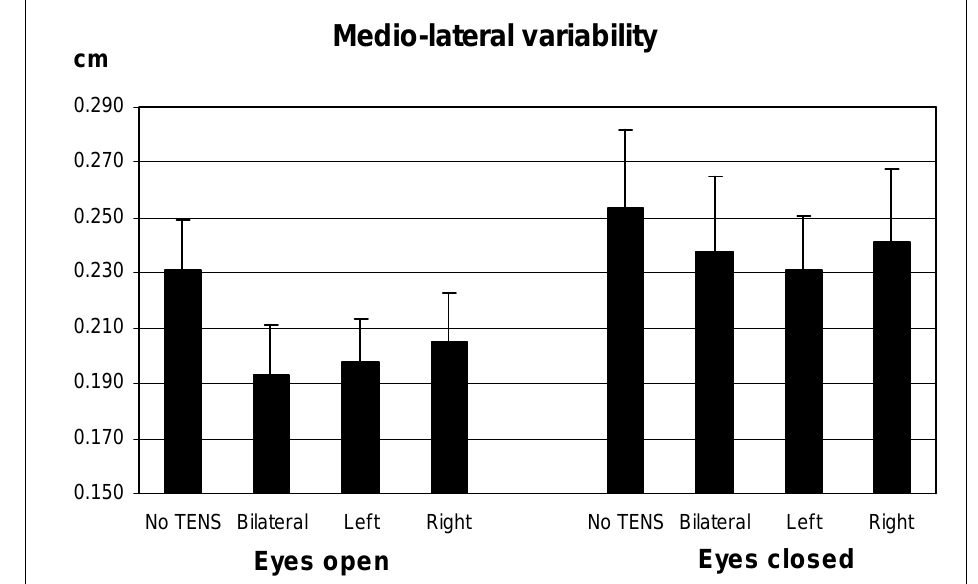
Figure 2. Mean and standard deviation of medio-lateral variability in each of the four TENS conditions with eyes open and eyes